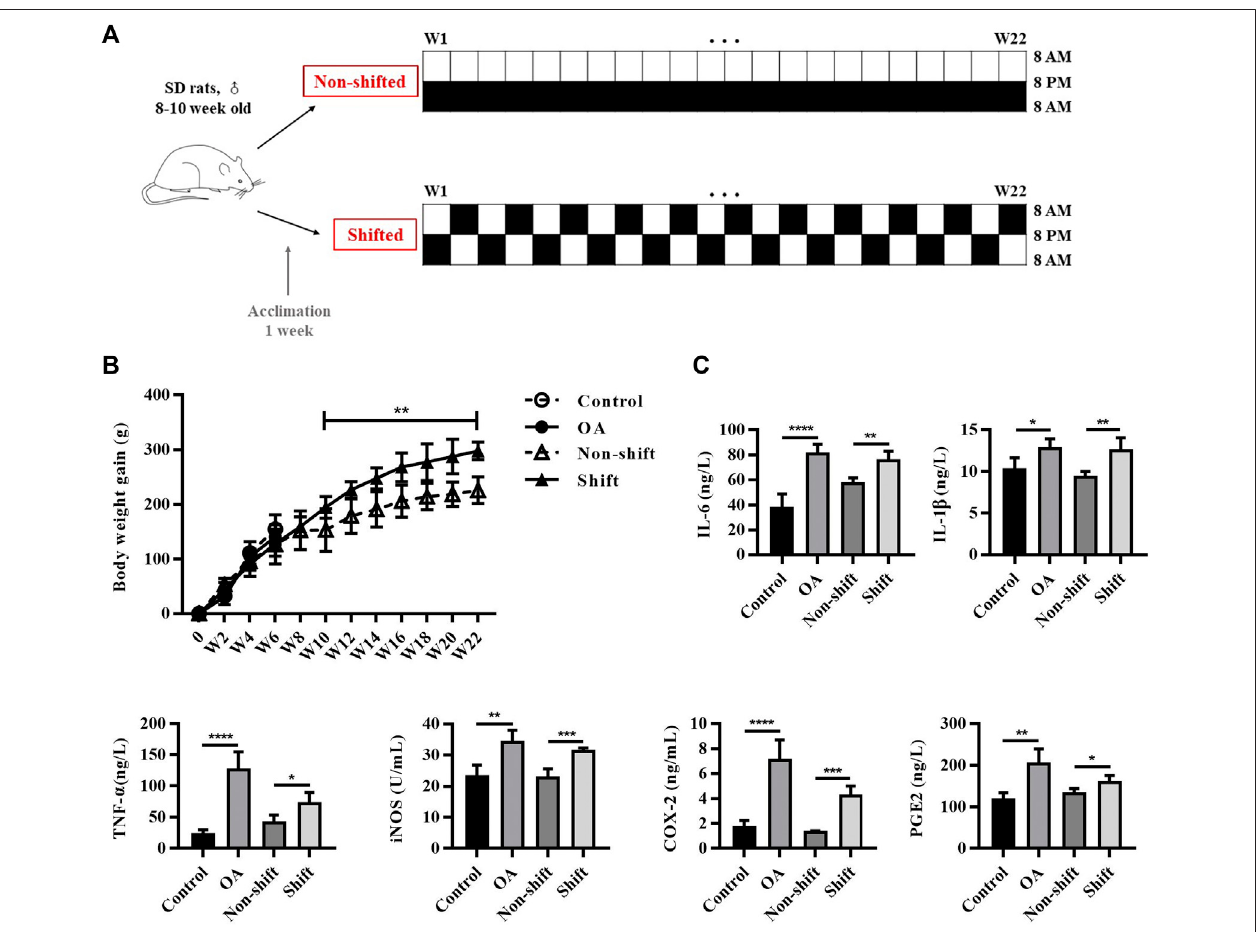
FIGURE 1 | Protocol of CRD-rat model and in fl ammatory response in rats after OA and CRD modeling. (A) Protocol of CRD-rat model and the control group. (B) Alterationsofbodyweightgainofratsindifferentgroups.Resultsareexpressedasmean ± SD; n (cid:2) 4 – 6.** p < 0.01betweentheshiftandnon-shiftgroup. (C) LevelsofIL- 1 β , TNF- α , IL-6, iNOS, COX-2, and PGE2 in rat serum in different groups. Results are expressed as mean ± SD; n (cid:2) 4 – 6. * p < 0.05, ** p < 0.01, *** p < 0.001 and **** p <